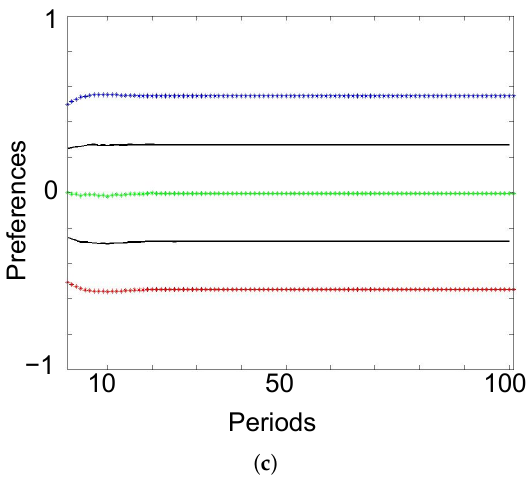
Figure 1. Evolution of individual preferences by communities in each period: ( a ) city residents; ( b ) hometown residents; ( c ) average preference of residents in each community. Each dot represents the preference of an agent at each period. Green is associated with the city, blue with town + and red with town − . In ( c ), black lines indicate preference thresholds, as defined in Equation (2).